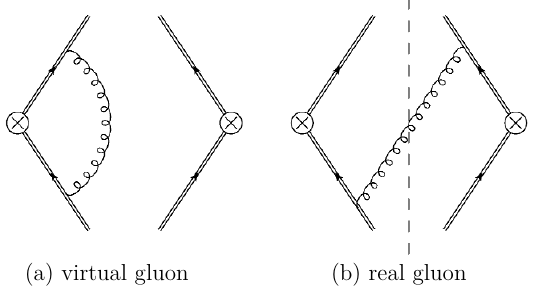
( α ) diagrams that contribute to the soft-collinear s O